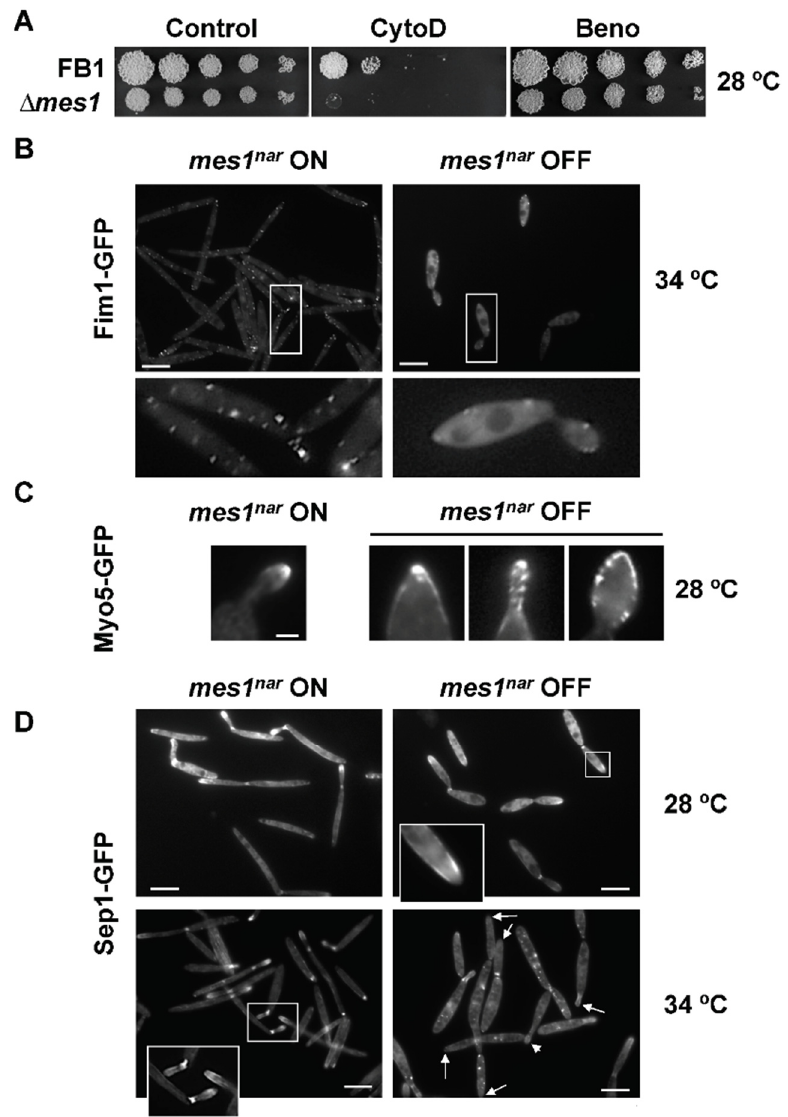
Figure 3. Mes1 and the actin cytoskeleton. ( A ) FB1 wild-type and FB1 ∆ mes1 strains were inoculated onto YPD plates containing 10 µ M cytochalasin D (CytoD) or 1 µ M benomyl (Beno), which disrupt actin cables or microtubules, respectively. ∆ mes1 strain was more sensitive to cytochalasin D but not to benomyl. AB31 mes1 nar strains harbouring a Fim1-GFP ( B ), Myo5-GFP ( C ), or Sep1-GFP ( D ) fusion were grown under inducing ( mes1 nar ON) or repressing ( mes1 nar OFF) conditions for mes1 at the indicated temperature. GFP fluorescence was visualized under the microscope. Lower panels in ( B ) or insets in ( D ) represent magnifications of the indicated areas. Bar size = 2 µ m. Septins are scaffolds necessary for the localization of factors involved in F ‐ actin re ‐ The increased sensitivity to cytochalasin D and the thermosensitivity of the ∆ mes1 strain suggested a putative connection between Mes1 and the actin cytoskeleton in U. maydis . To visualize the actin cytoskeleton, I employed a fimbrin-GFP fusion to tag status in the mes1 conditional mutant ( mes1 nar ). At 28 °C, Sep1 ‐ GFP localized to the bud F-actin in patches [29] and a Myo5-GFP fusion to analyse the functionality of the actin cables [44]. It is known that heat shock promotes depolarization of the actin [28]. At 34 °C, Sep1 ‐ GFP localization was not altered in the wild ‐ type strain. In the mes1 nar